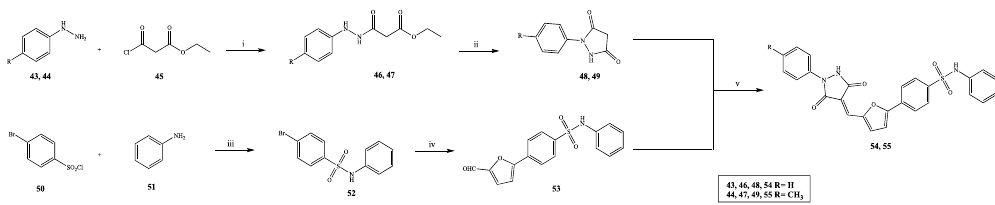
Figure 10. General synthetic procedure followed for the preparation of 54, 55. (i) NEt 3 , THF, r.t. 3 h; (ii) NaOH, EtOH, r.t. 30 min; (iii) pyridine, r.t. o.n.; (iv) K 3 PO 4 , Pd(dppf), H 2 O/DMF, 130 °C 75 min (microwave); (v) AcOH, 120 °C 3